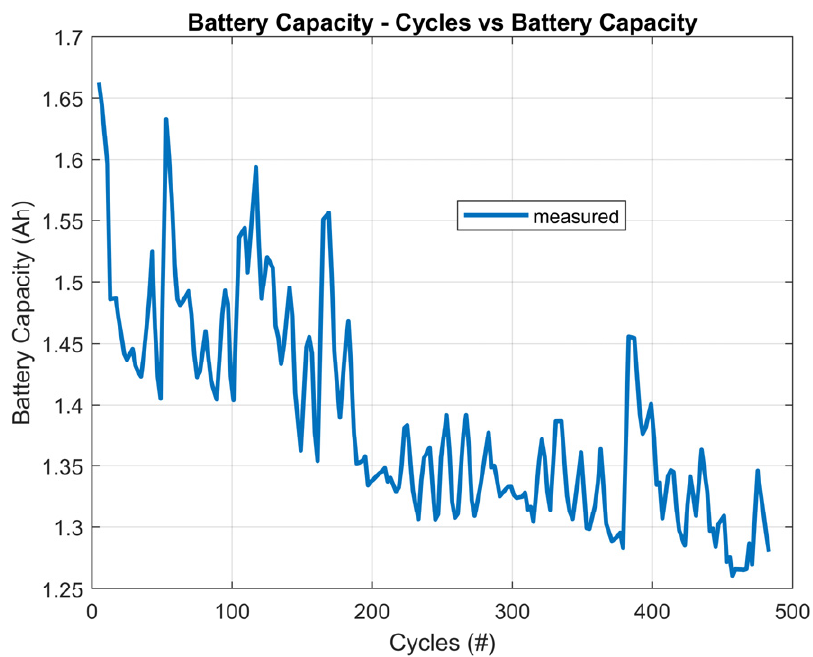
Figure 3. B034 Measured Battery Capacity at the end of each discharge cycle [22].